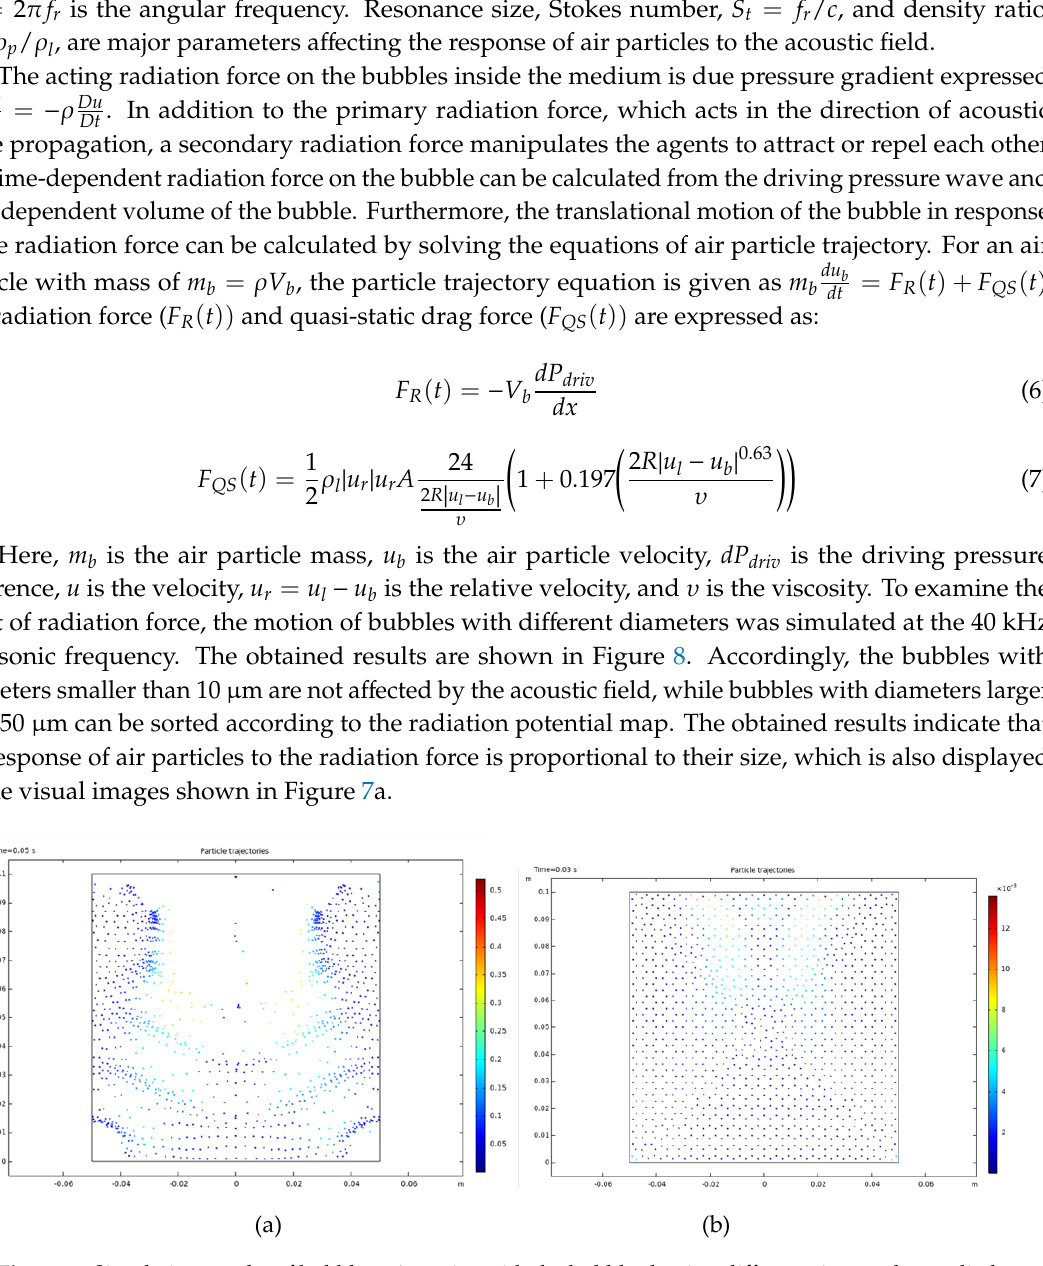
Figure 8. Simulation results of bubble trajectories with the bubbles having different sizes at the applied frequency of 40 kHz ( a ) Air bubble having 50 µm diameter; ( b ) Air bubble having 10 µm diameter.